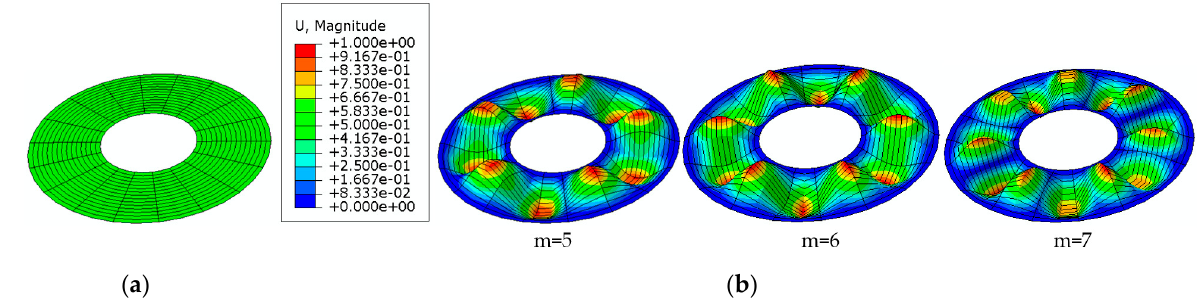
Figure 8. Homogeneous annular FEM plate model: undeformed view ( a ), modes m of the plate radially stretched on the inner edge with auxetic facings with Poisson’s ratio ν = − 0.3 ( b ).